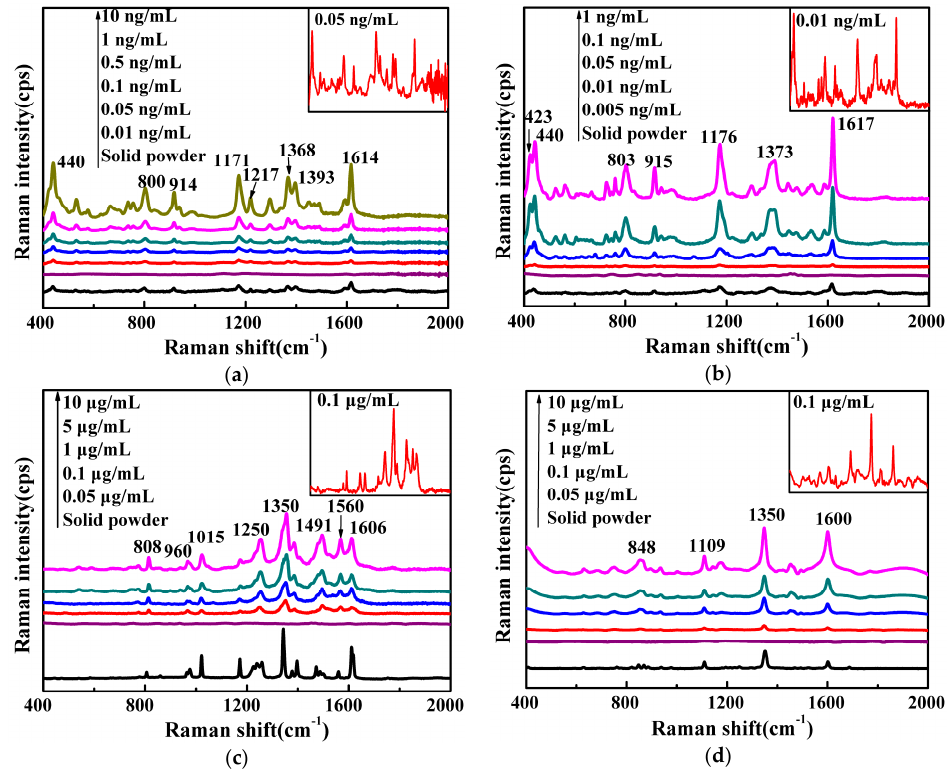
Figure 3. Raman and surface ‐ enhanced Raman scattering (SERS) optical spectra of ( a ) malachite green, ( b ) crystal violet, ( c ) furazolidone, ( d ) chloramphenicol.